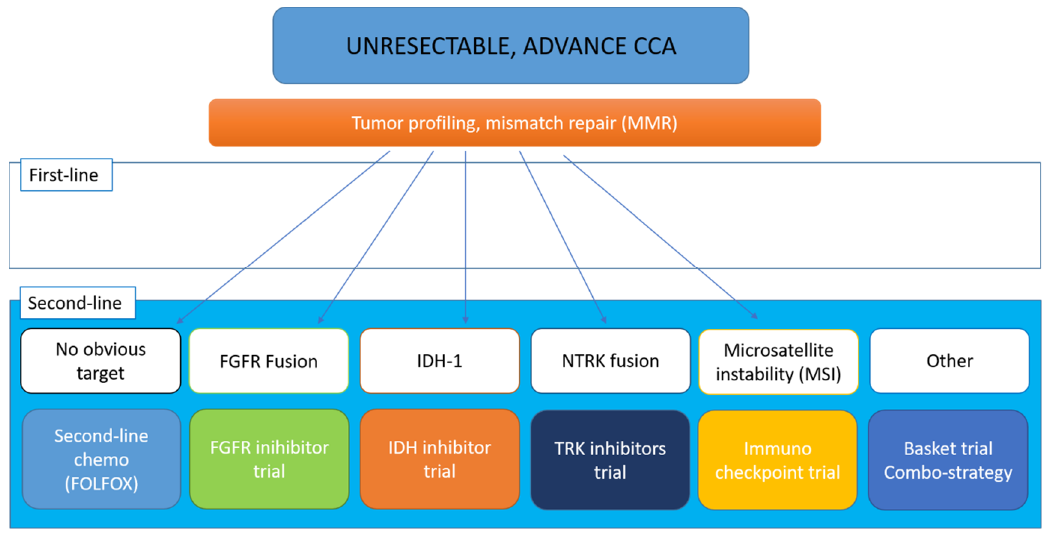
Figure 3. The landscape of targeted therapies for cholangiocarcinoma: current status and emerging